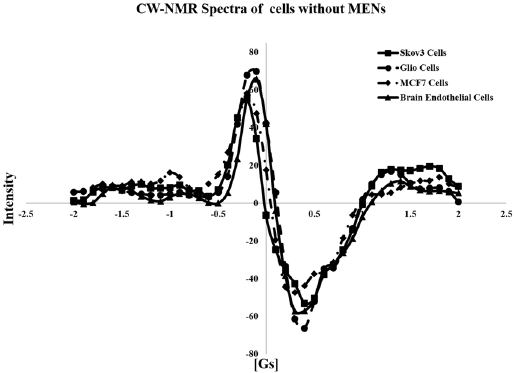
Figure 2. CW-NMR spectra of cell media without MENs for four types of cells: (i) ovarian carcinoma cells Skov3, (ii) glioblastoma cells U87-MG, and (iii) breast adenocarcinoma cells MCF-7, respectively, and (iv) normal brain endothelial cells.